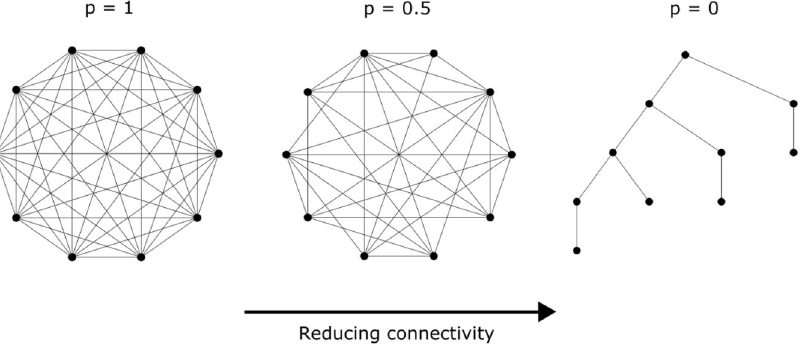
Figure 2. Connectivity reduction in small graphs. We start with a fully connected graph of size N and equal edge strength across the network = . Picking each edge at random, the edge is removed with probability ≠ A 1 ij,i j − 1 p . If removing the edge makes the graph disconnected, the action is reversed. We repeat the process of selection for removal for N